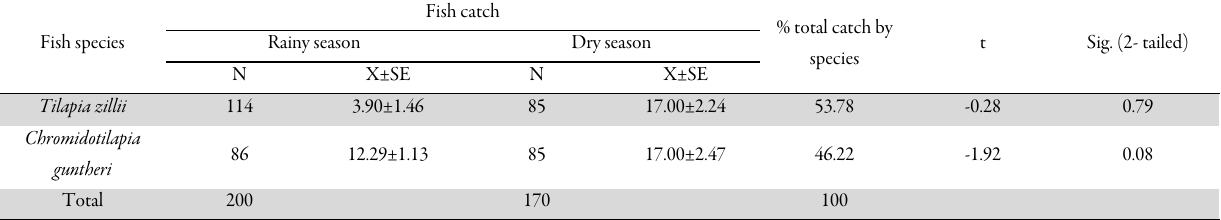
Table 1. Relative abundance and seasonal distributions of Tilapia zillii and Chromidotilapia guntheri from the Igun gold mine reservoir Fish catch Fish species